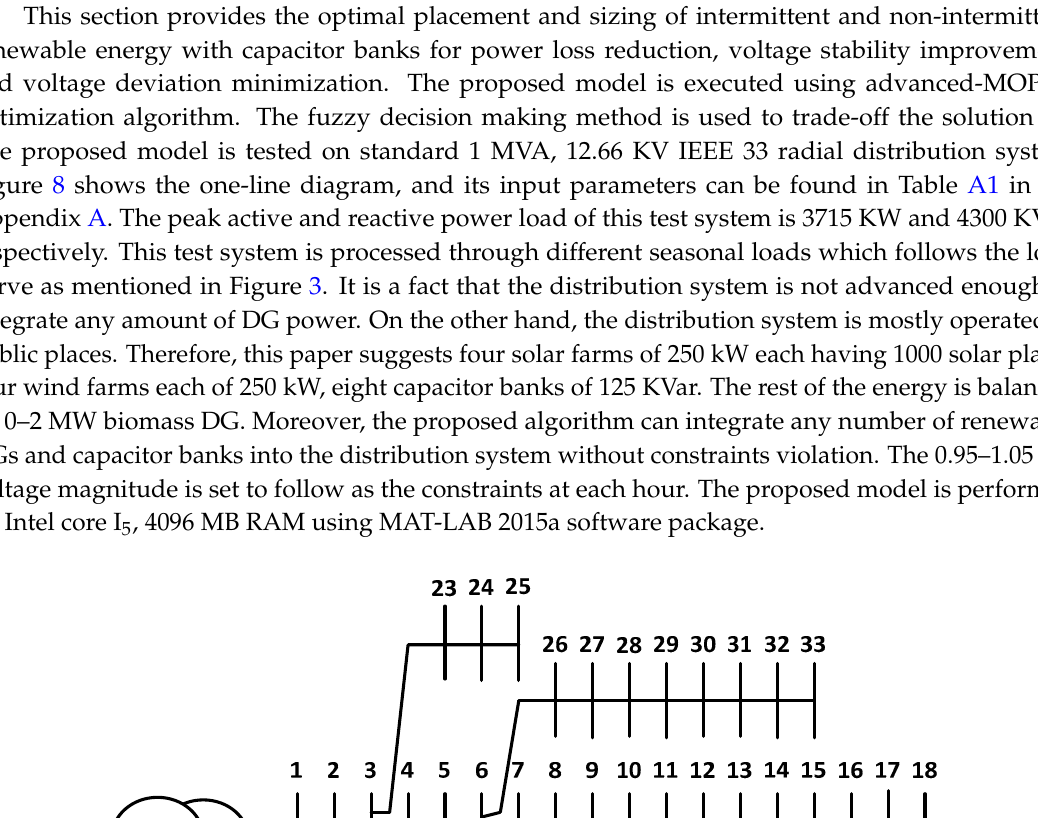
Figure 7. Power output of solar irradiance